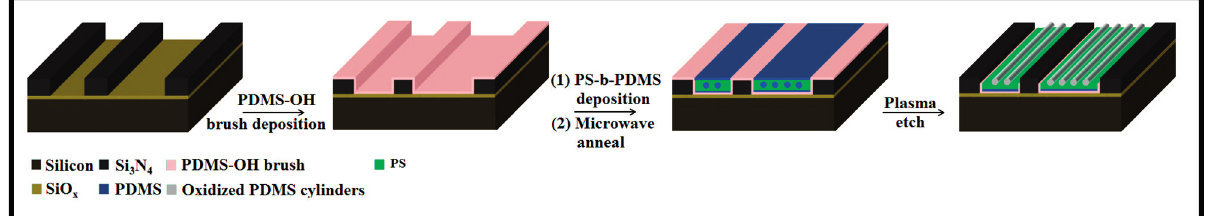
Figure 6. Top-down SEM images of the PS- b -PDMS pattern formed on PDMS-OH brush modified patterned Si 3 N 4 substrate Data shown are with Si 3 N 4 mesa and channel widths of ( a ) 500 and 150 nm; ( b ) 500 and 200 nm; and ( c ) 1500 and 500 nm, respectively.